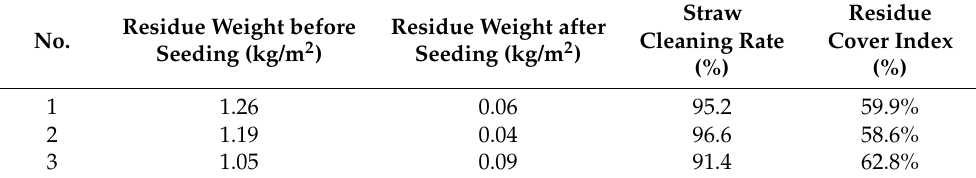
Table 7. Wheat residue changes before and after seeding.